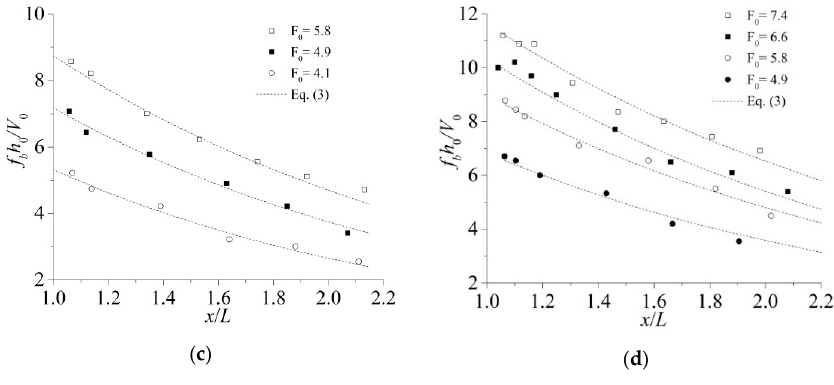
Figure 4. Bottom air bubble frequency along the chute ( a ): S2; ( b ): S3; ( c ): S4; ( d ): S5.